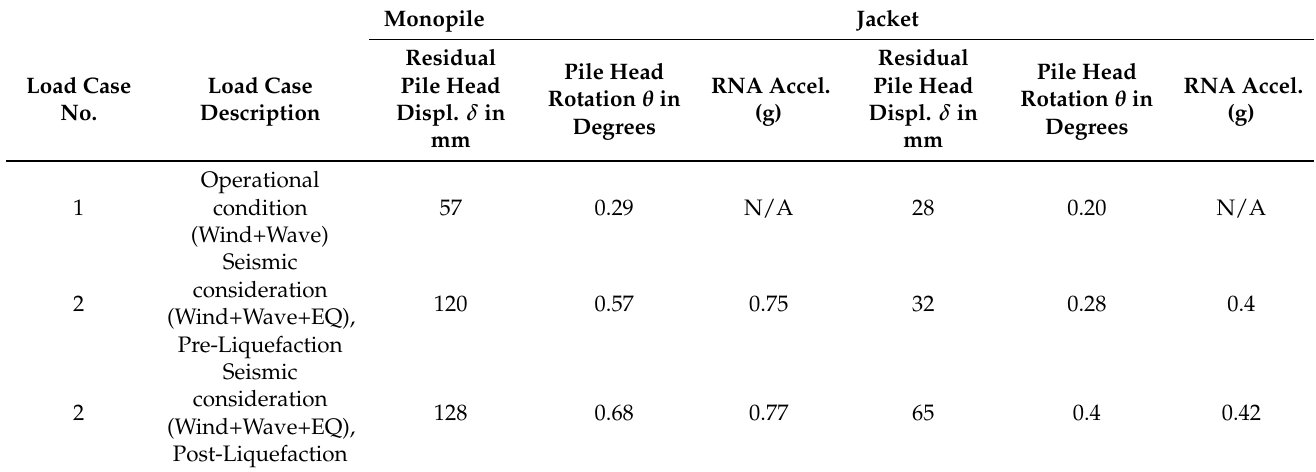
Table 6. Key results of the